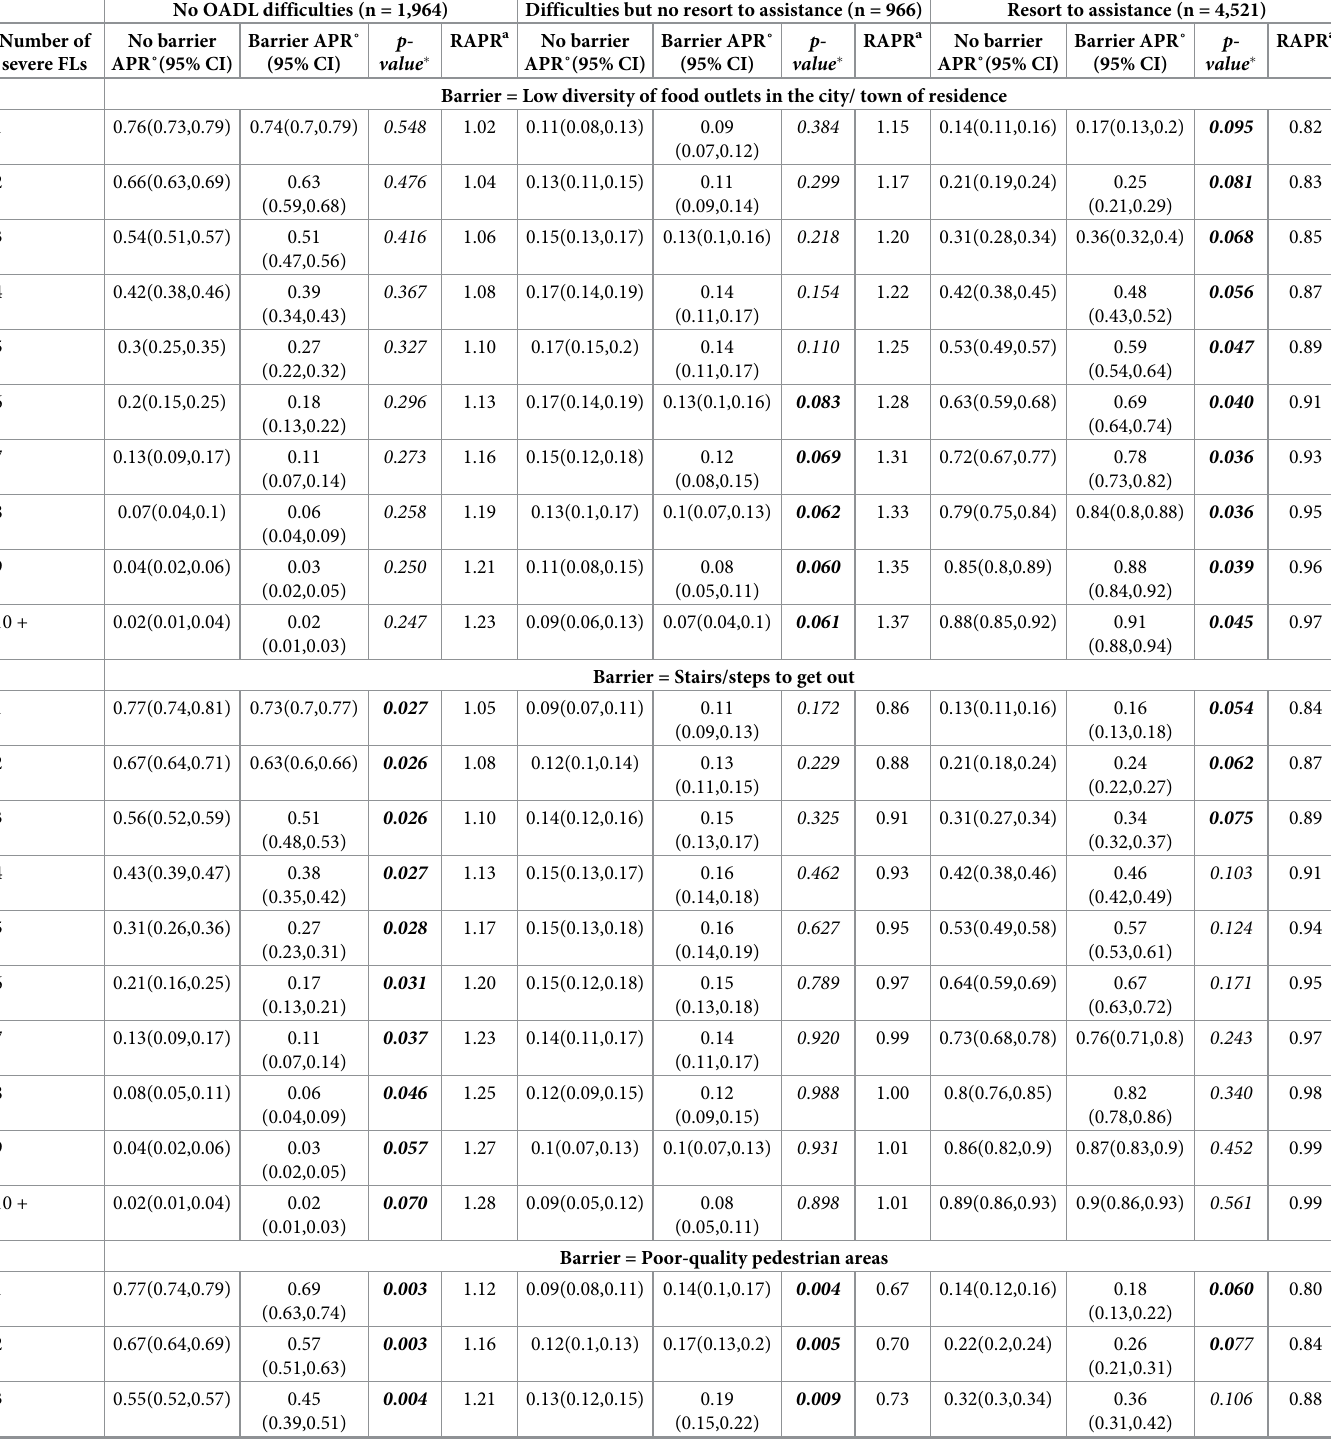
Table 3. Relative Adjusted Predictions at Representative values ˚ (APRs) of OADL difficulties and resort to assistance, for 1 to 10+ severe FLs (Calculations based on APRs estimated in model 2). CARE-Seniors Me´nages Survey (60+ with at least 1 FL) 2015,